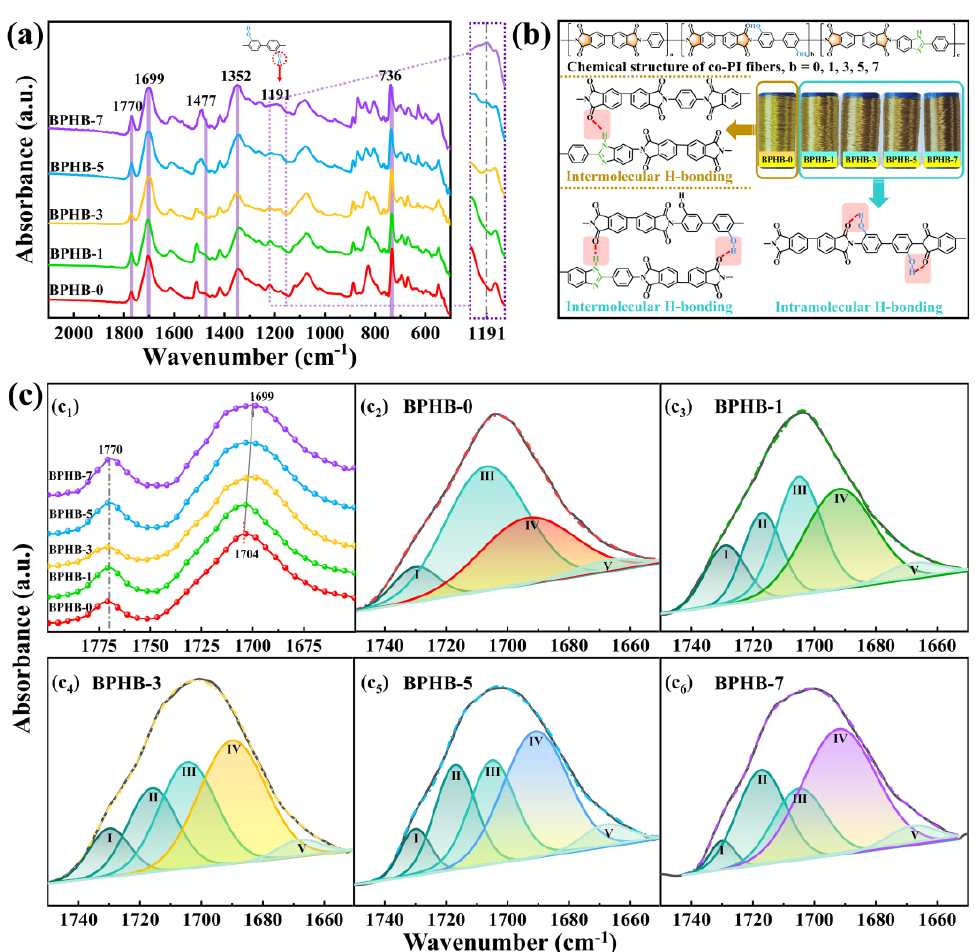
Figure 1. ( a ) ATR – FTIR spectra of the PI fibers with the different p -PDA/HAB/BIA molar ratios. ( b ) Intra-/intermolecular H-bonding interactions in BPHB fibers. ( c 1 ) Magnified ATR – FTIR spectra of PI fibers at the wavenumber range of 1800 – 1650 cm − 1 ; ( c 2 – c 6 ) curve-fitting ATR – FTIR spectra in the wavenumber range from 1650 cm − 1 to 1750 cm − 1 .